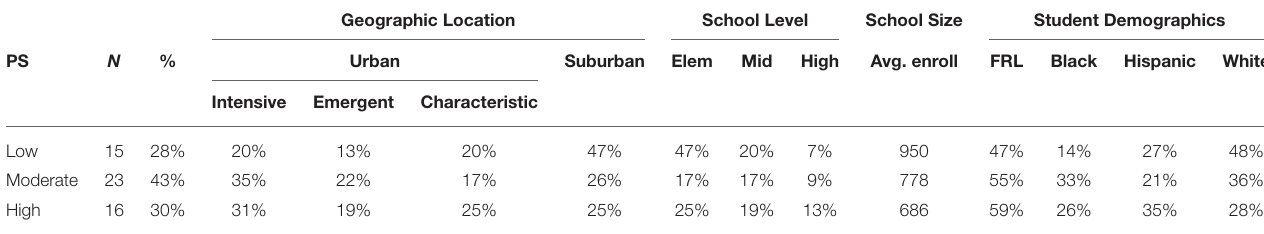
TABLE 2 | Levels of psychological safety and selection environmental conditions of schools. Geographic